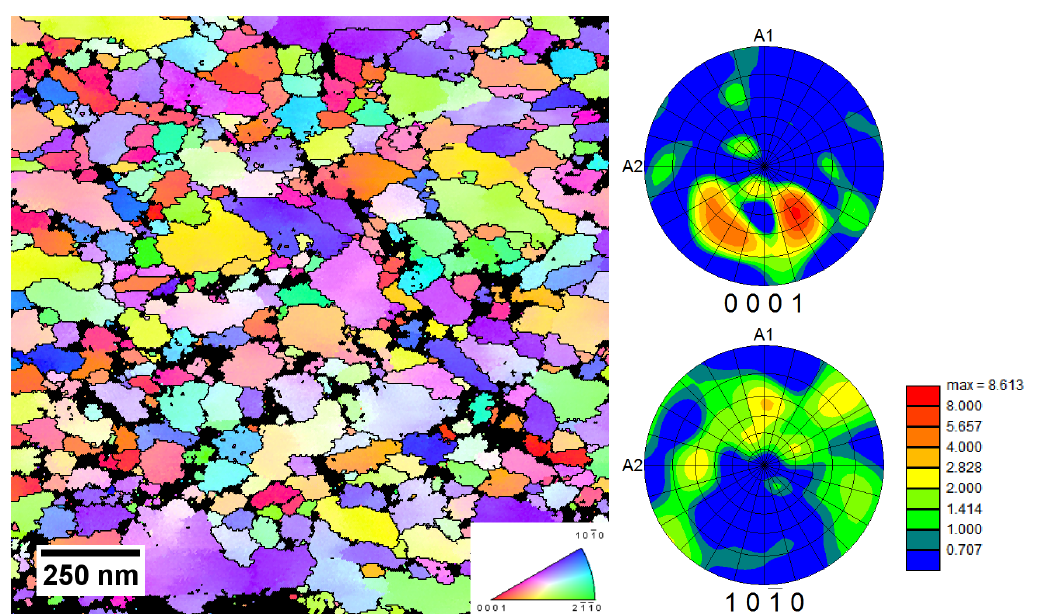
Figure 5. IPF map and corresponding pole figures of a milled powder sample. Scanned area 1.5µm × 1.5µm, step size 5nm, only well indexed points are shown. High angle grain boundaries (>15 ◦ ) are marked by black lines. The axes A1 and A2 in the pole figures correspond to the axes shown in Figure3.